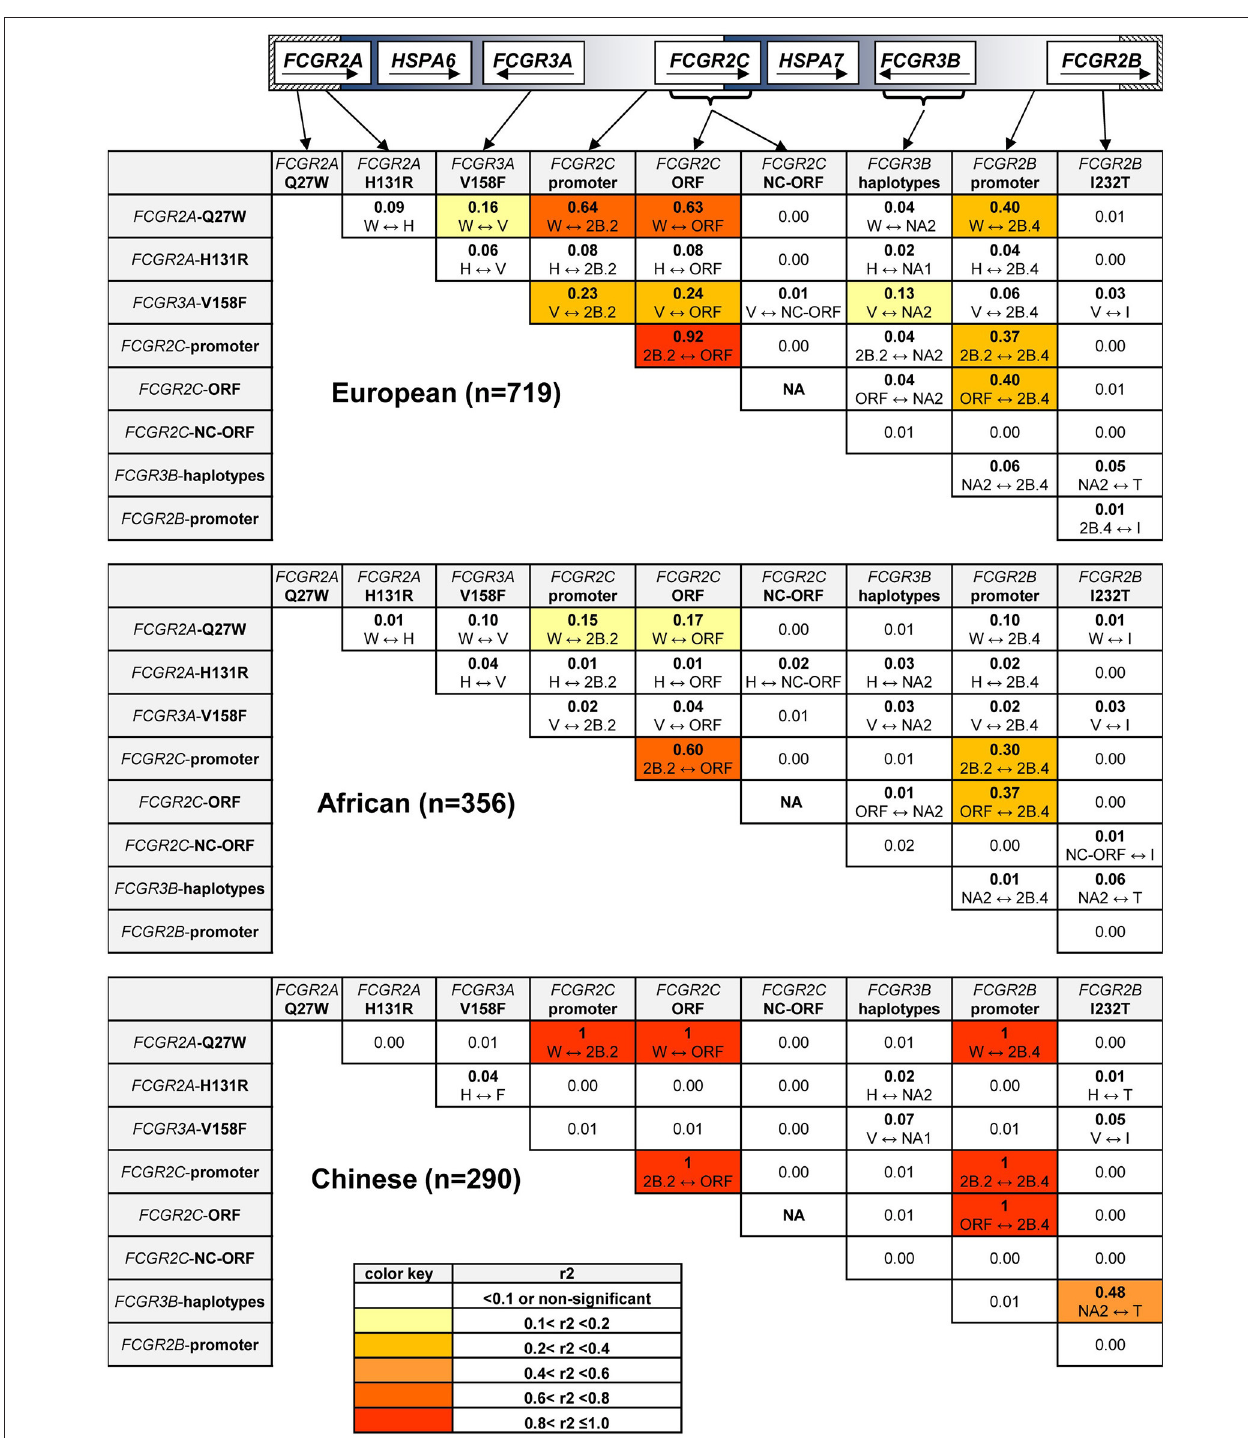
FIGURE 3 | Linkage Disequilibrium at the FCGR2/3 locus. Linkage Disequilibrium for SNPs and haplotypes in individuals without CNV. r 2 is shown for all combinations, which variant is linked to which variant is shown underneath. Values shown in bold are significantly different from 0 ( p < 0.05). FCGR2C -ORF = classic FCGR2C -ORF haplotype vs. all other FCGR2C haplotypes. FCGR2C -NC-ORF = nonclassic FCGR2C -ORF haplotype vs. all other FCGR2C haplotypes. NA, not available, because the classic FCGR2C -ORF haplotype and nonclassic FCGR2C -ORF haplotype are mutually exclusive. Polymorphic amino acids are indicated by one-letter code.